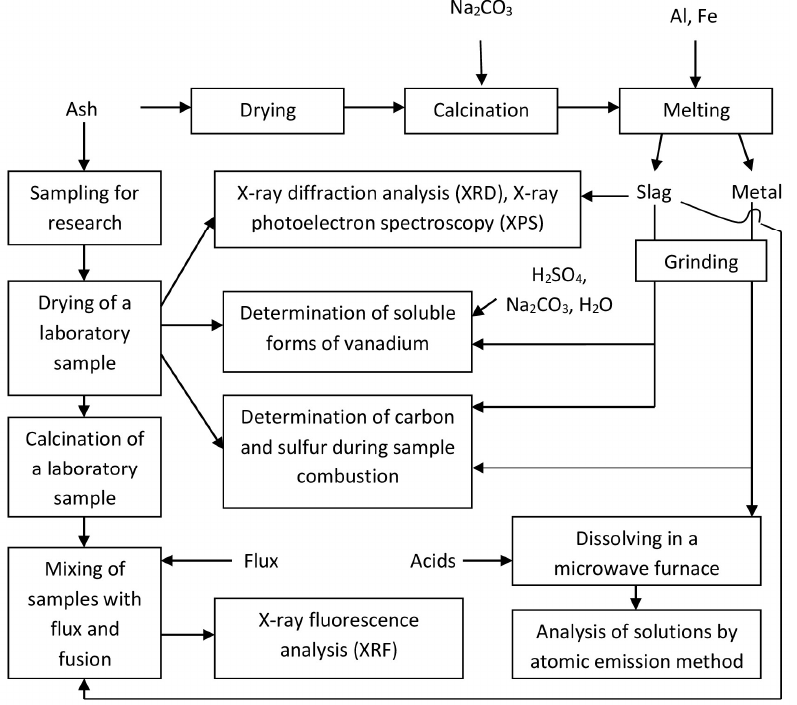
Figure 1. The scheme of processing and research of ash and its products.